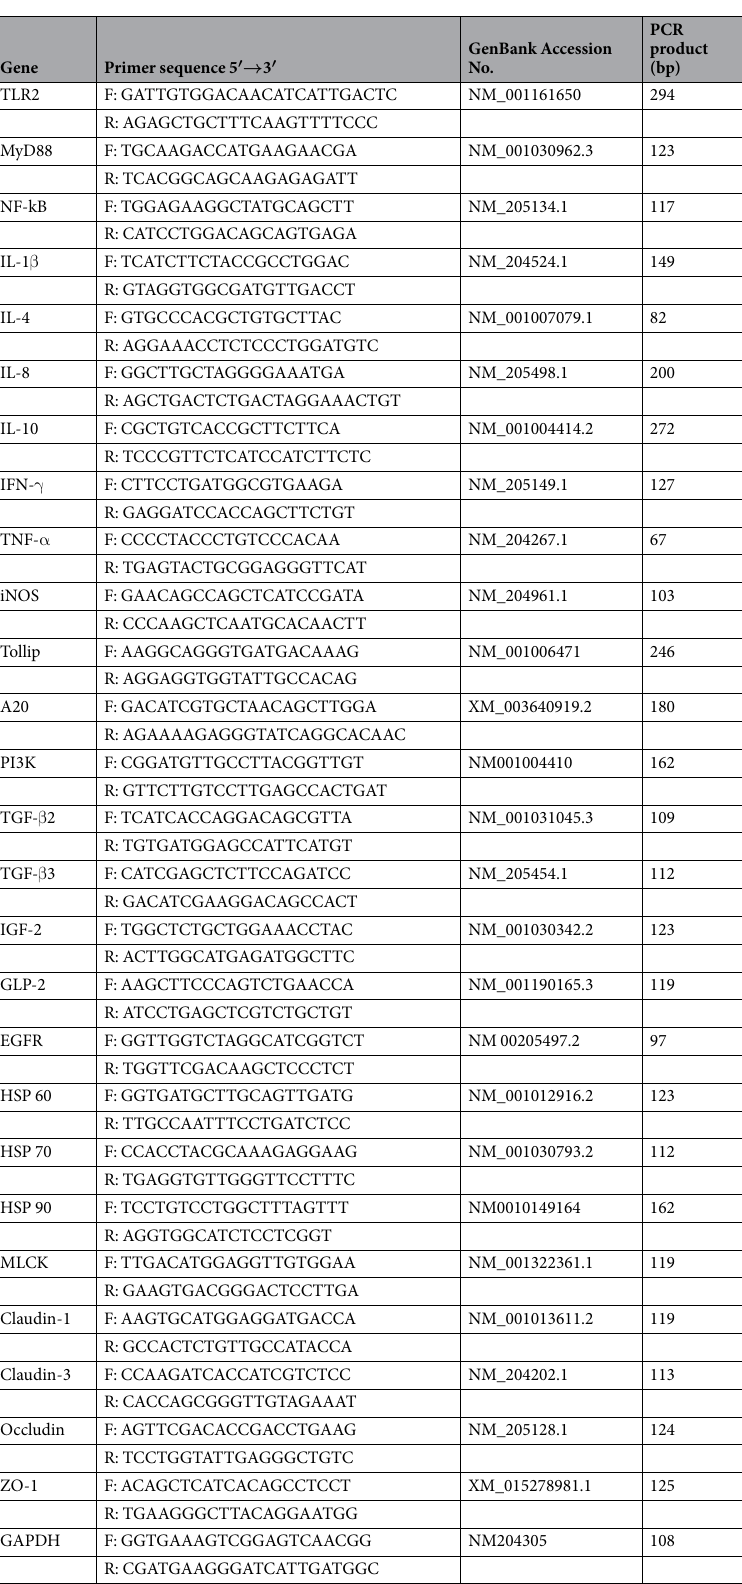
Table 5. Sequences of the oligonucleotide primers used for quantitative real-time PCR for immune-related gene expression a . a Primers were designed and synthesized by Sango Biotech (Shanghai) Co., Ltd. F: forward; R: reverse. TLR-2, toll like receptor-2; MyD88, myeloid differential protein-88; NF- κ B, nuclear factor kappa- light-chain-enhancer of activated B cells; HSP, Heat Shock Protein; MLCK, Myosin Light Chain Kinase; ZO-1, Zonula